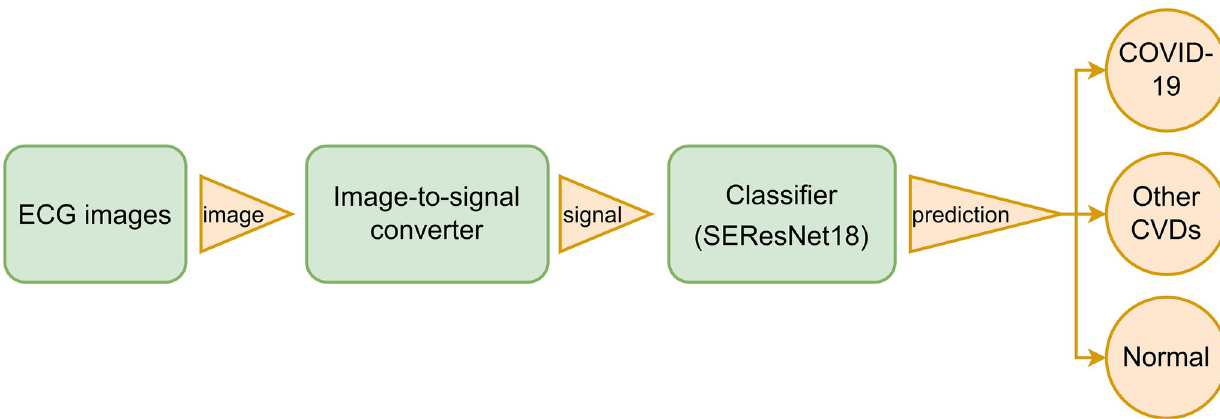
Fig 1. Schematic diagram of COVID-19 identification system. The process consists of 2 steps: converting ECG images to signals and classifying the resulting ECG signals.